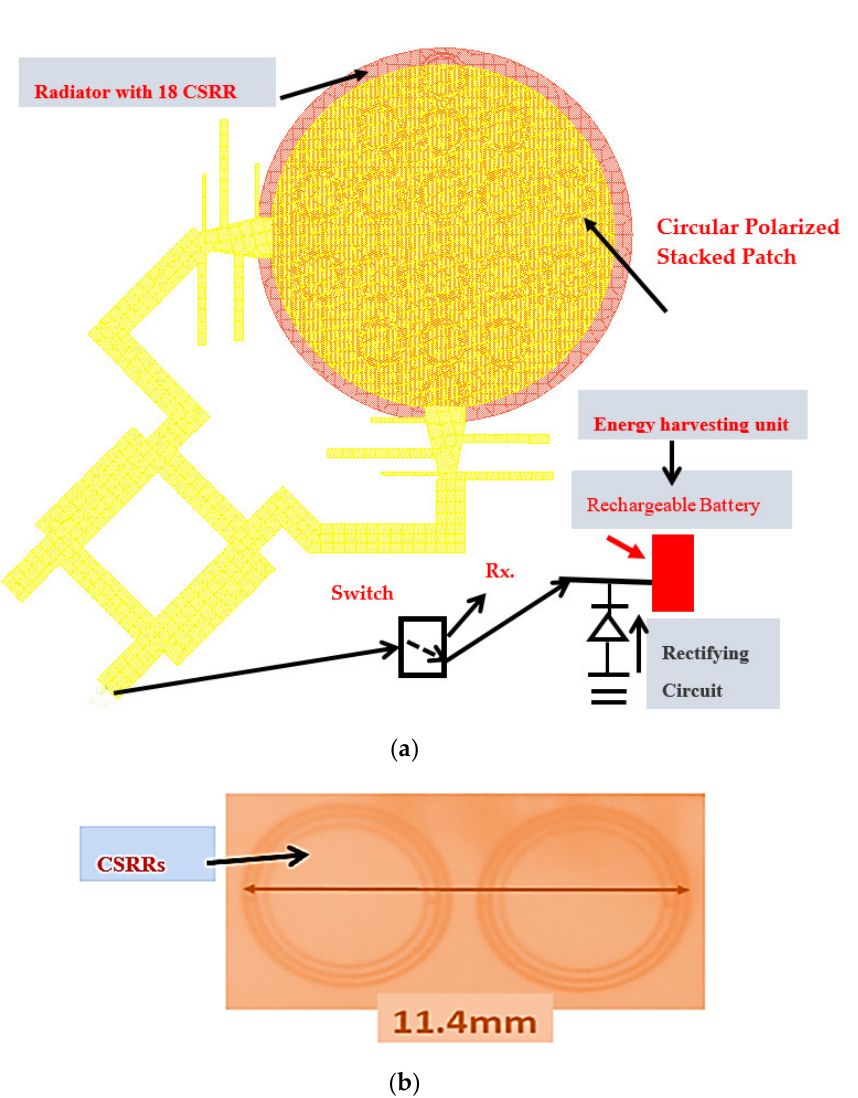
Figure 17. Wideband Metamaterial Circular Polarized Sensor ( a ) Antenna; ( b ) CSRRs Photo.